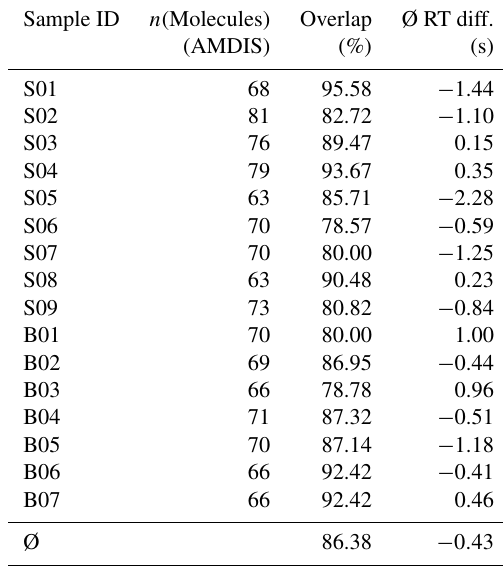
Table 1. Results of the comparison between analysis in AMDIS and semi-automated